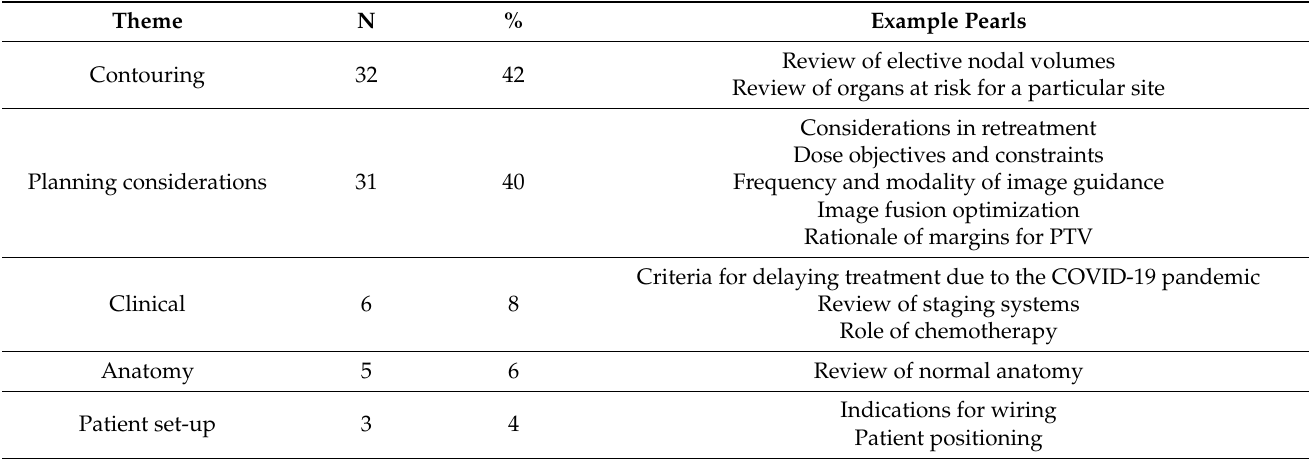
Figure 3. Outcomes as a result of the implementation of the RECOVR program. ( a ) Plot of cumulative resident-contoured cases as a function of weeks since April 1, 2020. ( b ) We observed a significant increase in the number of resident-contoured cases in Phase II compared to Phase I. ( c ) There was a significant difference in the proportion of formats of contour review between Phase I and II. * p < 0.05. Table 1. Example learning pearls grouped by